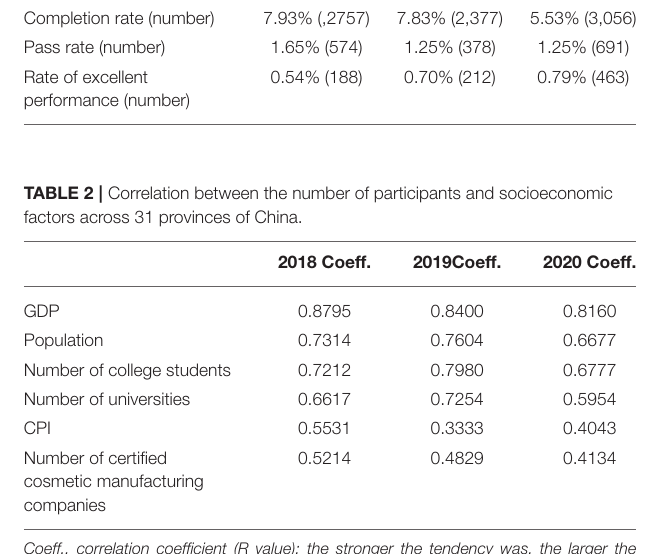
2020 after the outbreak of the pandemic.